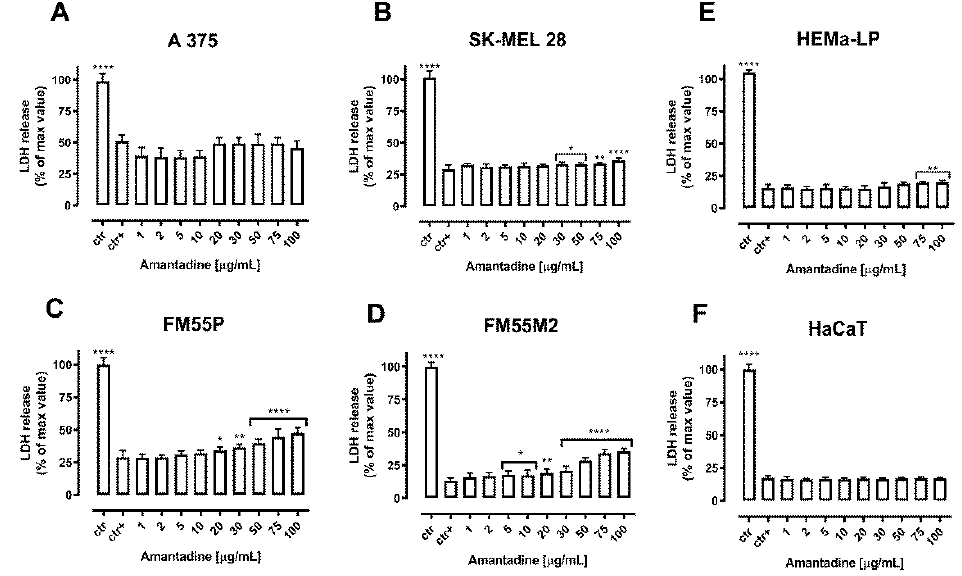
Figure 3. Cytotoxicity of amantadine to malignant melanoma cells (A375 ( A ), SK-MEL28 ( B ), FM55P ( C ), FM55M2 ( D )), melanocytes (HEMa-LP ( E )) and keratinocyte (HaCaT ( F )) measured by LDH assay. Results are presented as the percentage in LDH release to the medium by treated cells versus cells grown in control medium (ctr+) and cells treated with Lysis buffer (ctr). Data are presented as mean ± S.E.M. * p < 0.05, ** p < 0.01, **** p < 0.0001.